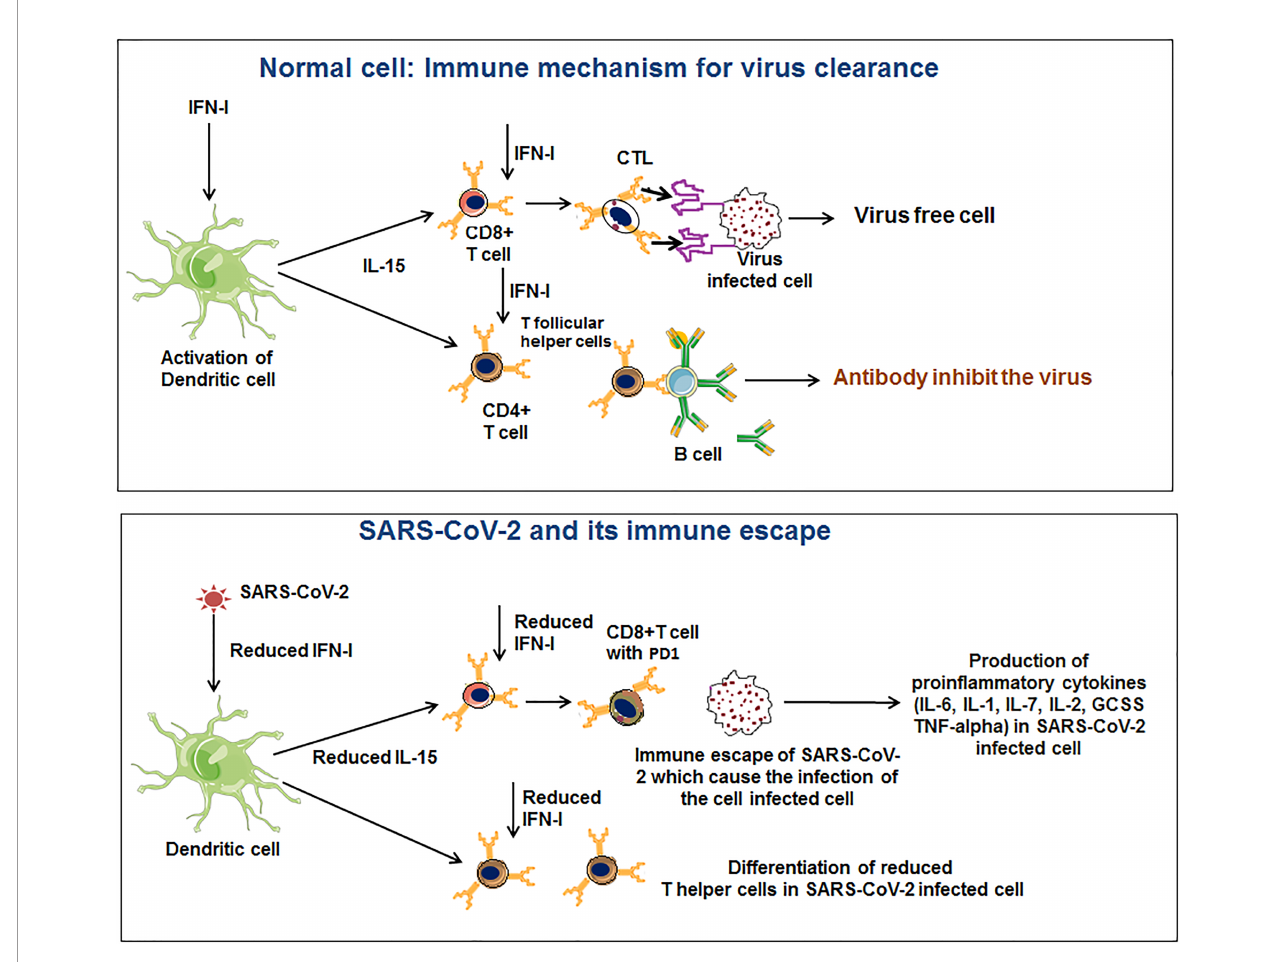
FIGURE 3 | SARS-CoV-2 innate immune evasions through modulation of the dendritic cell (DC)